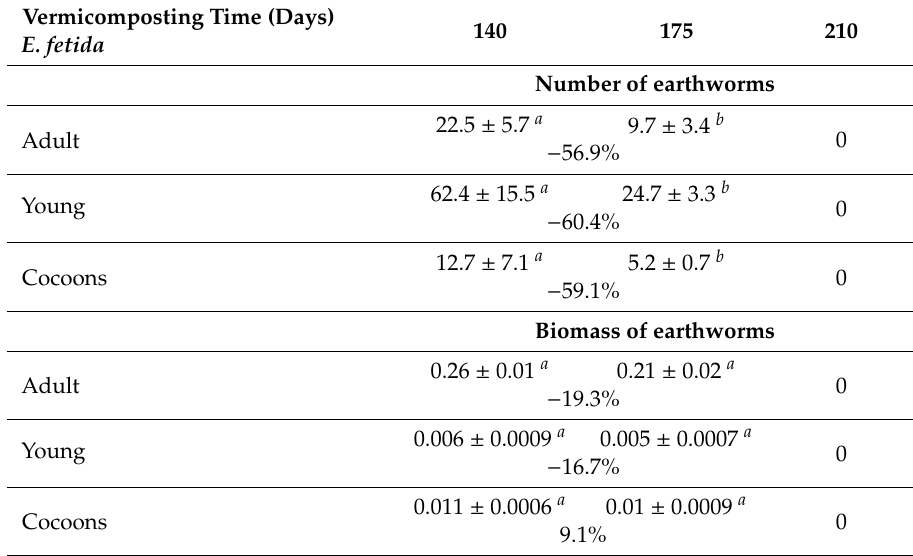
Table 3. Dynamics of the mean number and weight of adult specimens, young specimens and cocoons of E. fetida in the process of vermicomposting of biomass of T. latifolia (from day 140 to day 210 of the